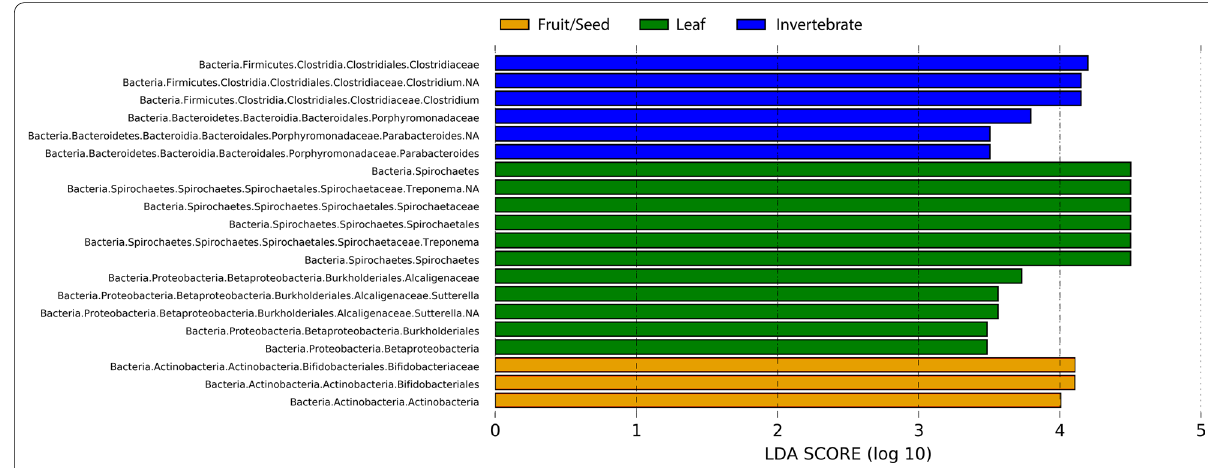
Fig. 5 Differentially abundant bacterial taxa among the three dietary seasons estimated by